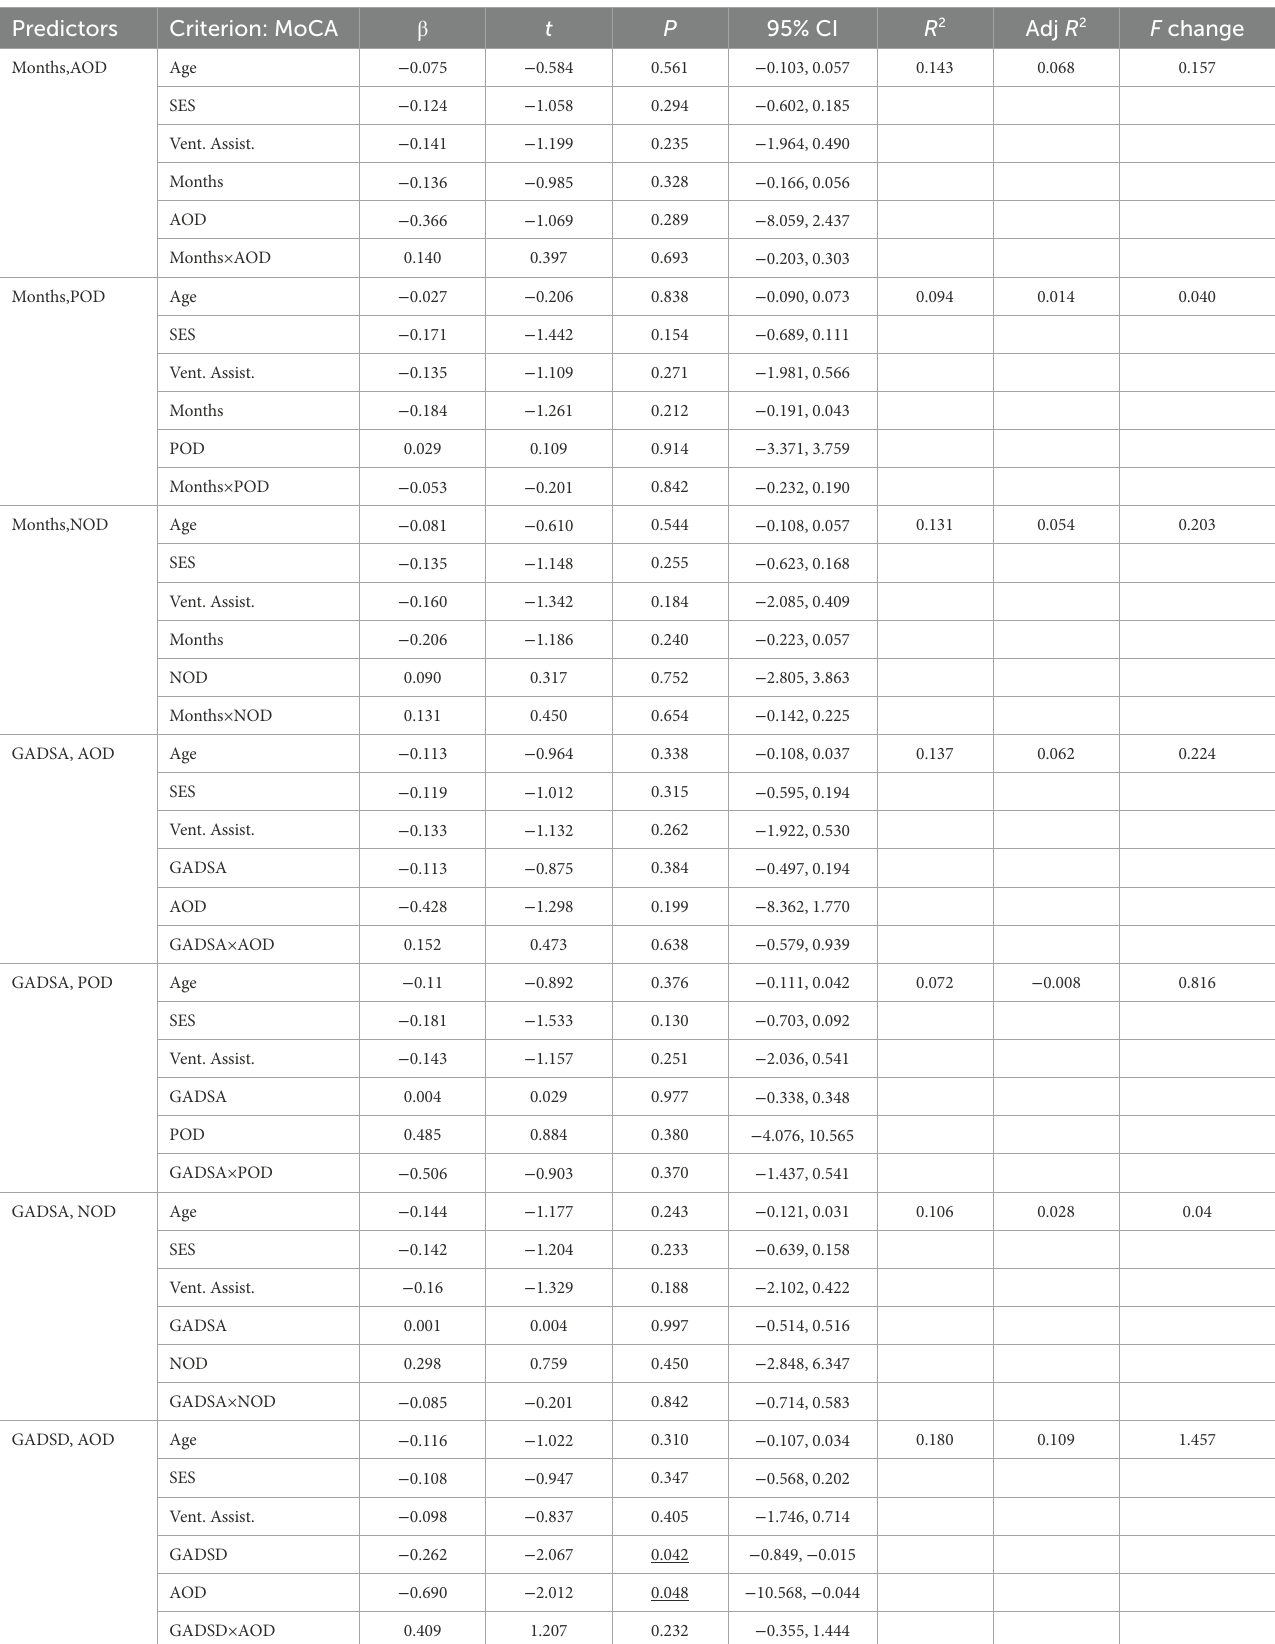
TABLE 6 Multiple regressions predicting general cognitive function (MoCA score), with months since COVID-19 onset, symptoms of anxiety and depression, trait-anxiety, and olfactory dysfunction as predictors.